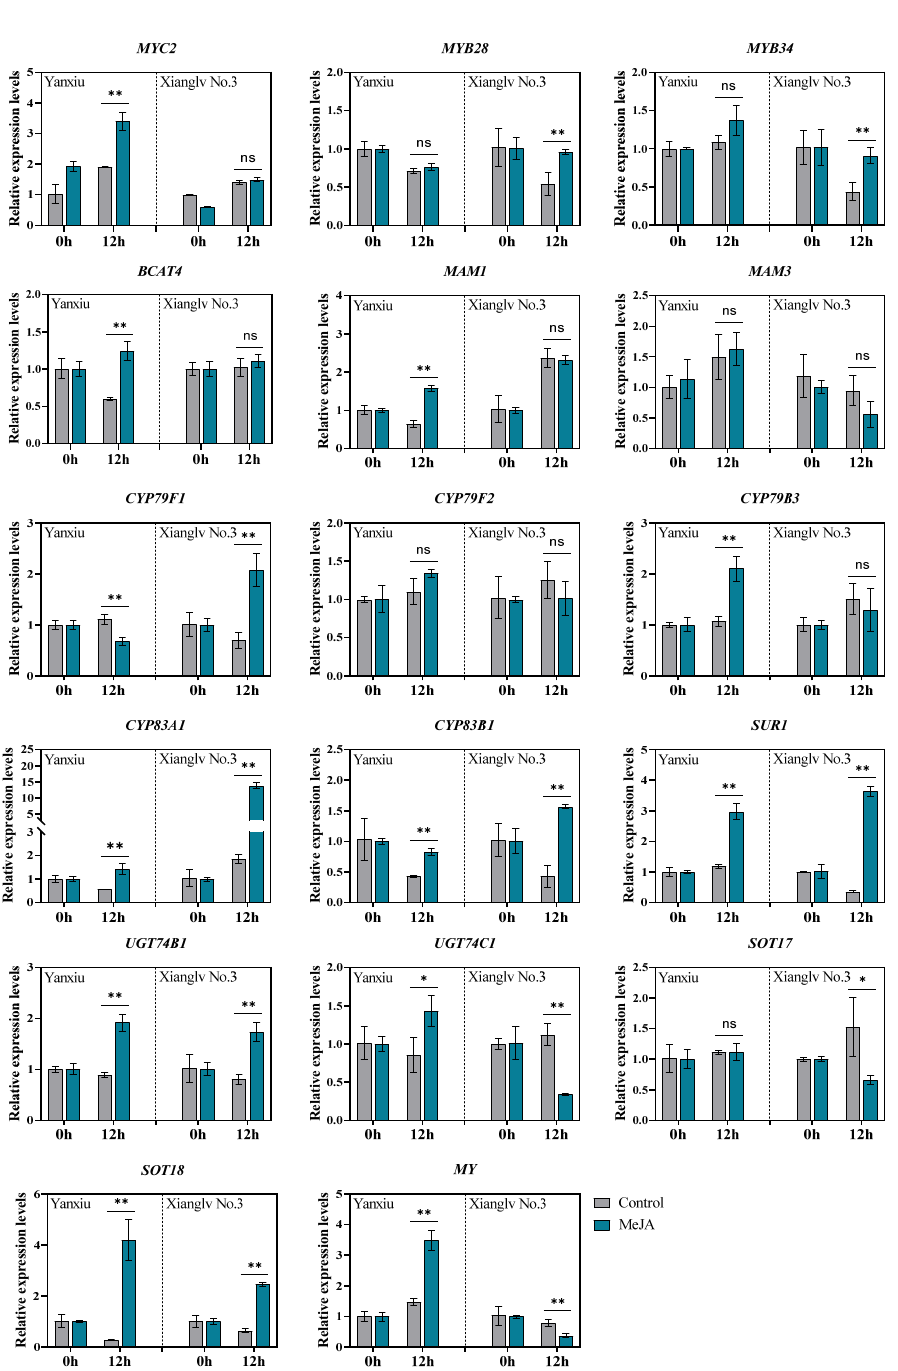
between both cultivars, which was significant induced in ‘Yanxiu’ and suppressed in ‘Xianglv No. 3’.